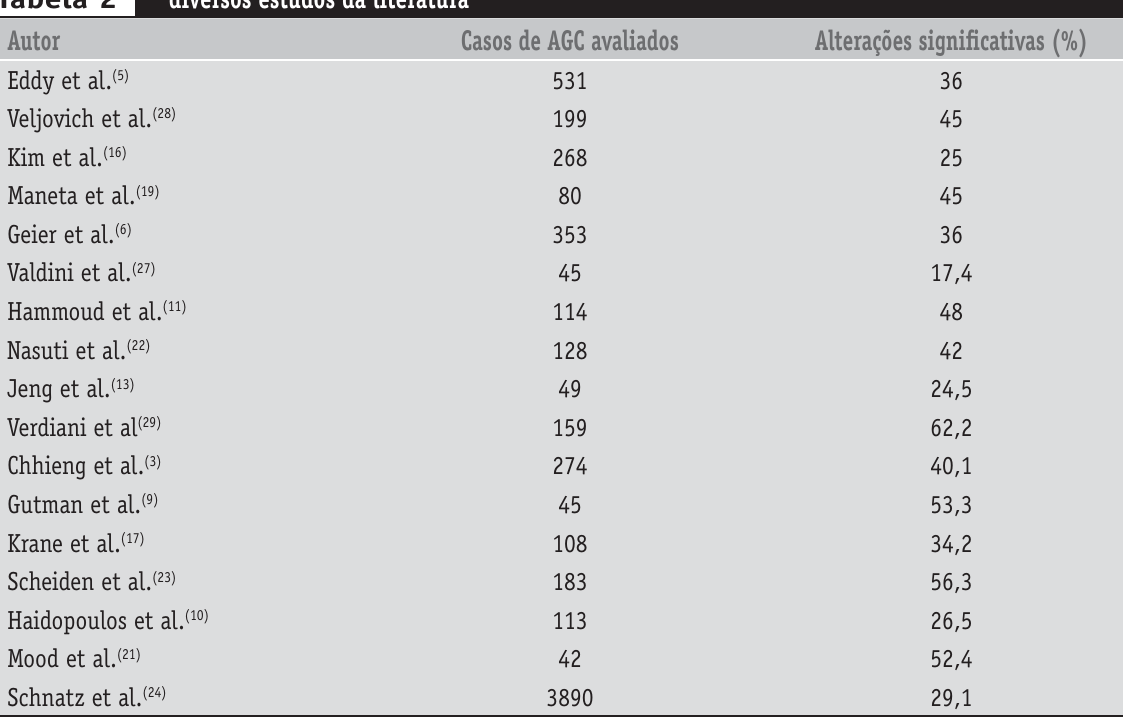
mais freqüentemente encontrados em diversos estudos da literatura relacionados ao tema. Nessa tabela também podemos observar que as NICs são as lesões histológicas mais comumente